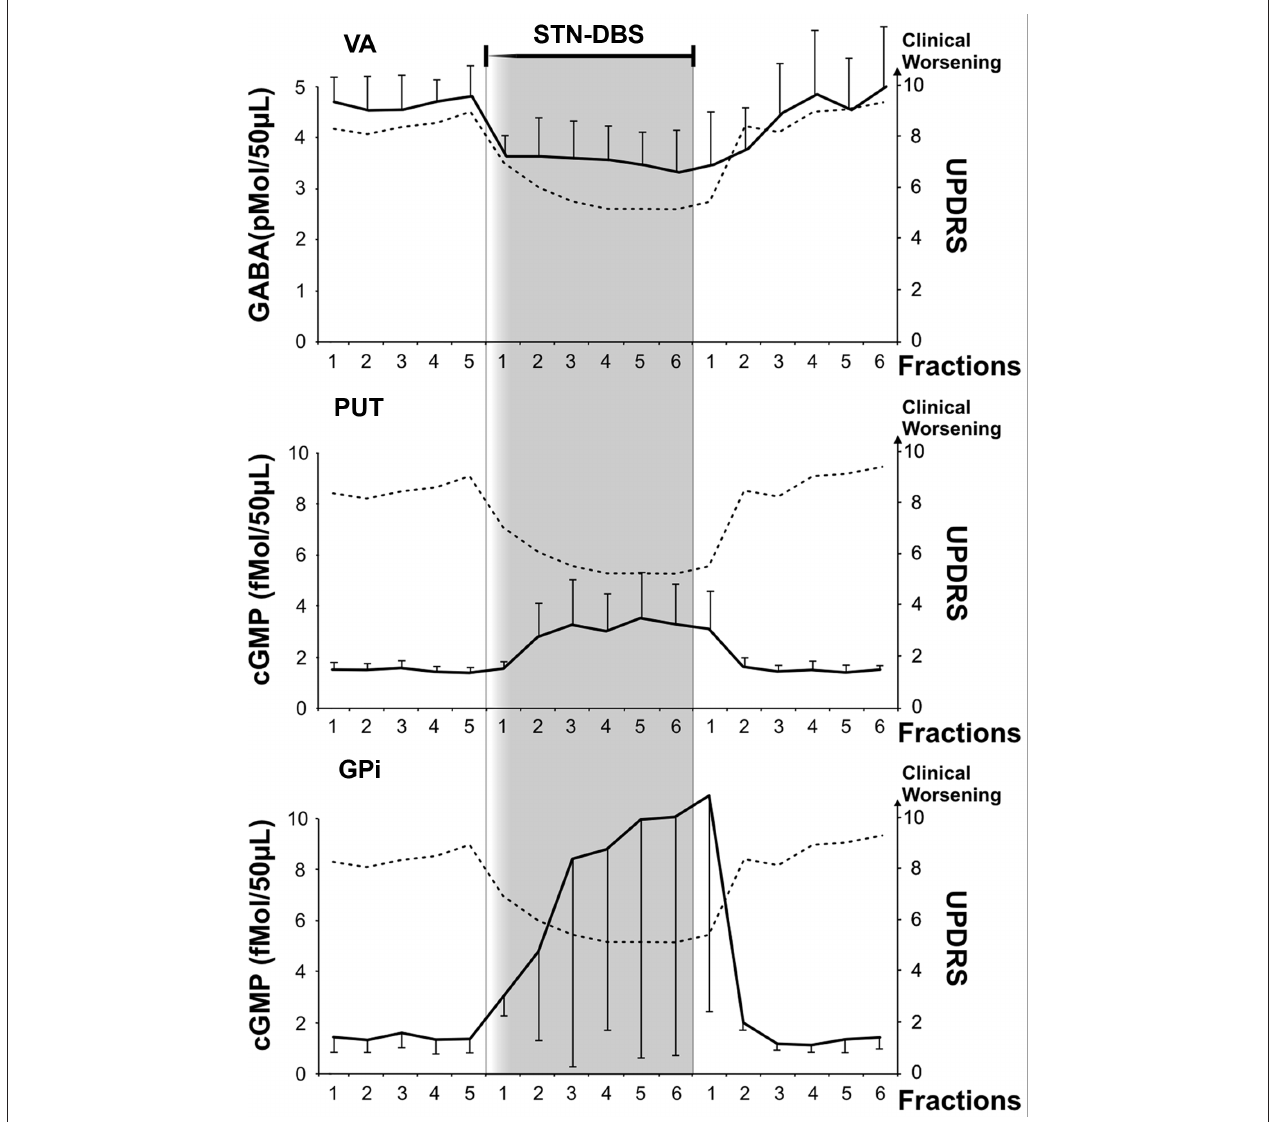
FiGURe 2 | Microdialysis data from VA, PUT and GPi and clinical evaluation before, during and after STN-DBS. Microdialysis probes were infused (5 μl/min) for stabilization (90 min). During stabilization, the permanent stimulating electrode (Medtronic mod 3389) was implanted in ipsilateral STN. Following STN electrode insertion and probe stabilization, collection of 10-min fraction samples (50 μl each) started. The first five fractions of each probe were utilized for basal evaluation either for GABA (VA probe, scale on the left y axis in pmol/50 μl) or for cGMP (PUT and GPi probes, scale on the left y axis in fmol/50 μl). Basal values are in the white area at the left of the shaded area. Values represent mean ± SD. After Medtronic mod 3389 electrode implantation, monopolar STN-DBS was then switched on by a Medtronic external device Model 3625 at a rate between 130 and 160 Hz, anodal pulse of 60–90 μs, and voltage progressively increased by steps of 0.1 V up to the appearance of side effects (paresthesia or dystonia or myoclonus). Voltage was never above 3.0 V. Voltage stimulation was then decreased by 10% or more to obtain disappearance of clinical side